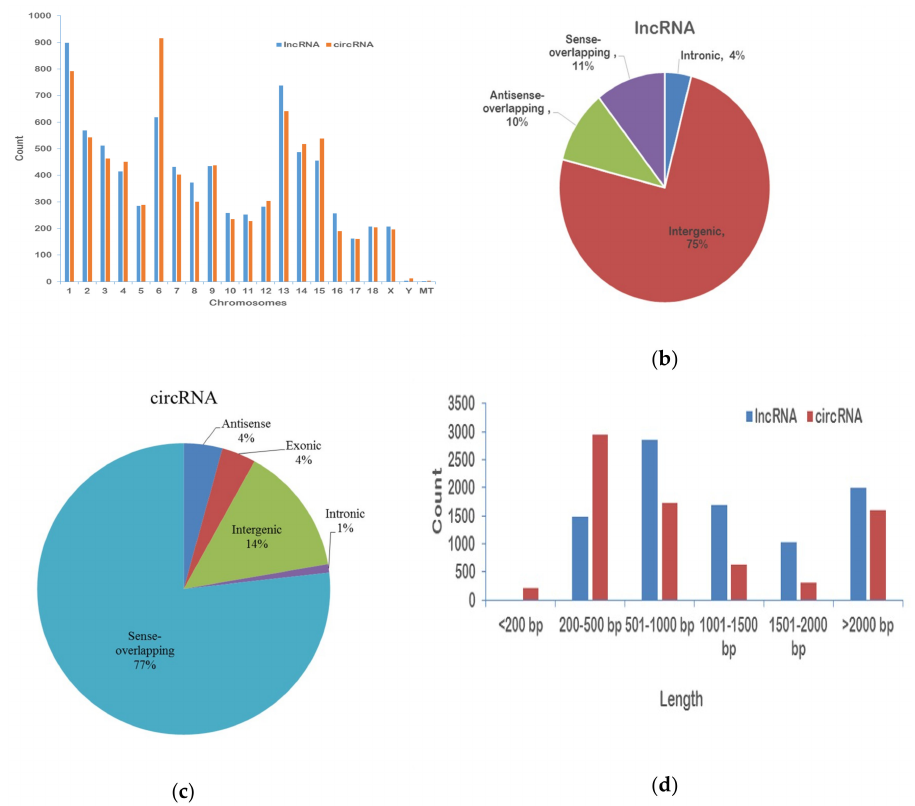
Figure 1. Comparison of the features of lncRNA and circRNAs in the porcine longissimus muscle. Chromosomes ( a ), genome ( b , c ) and length distribution ( d ) of lncRNA and circRNAs. Note: MT shows